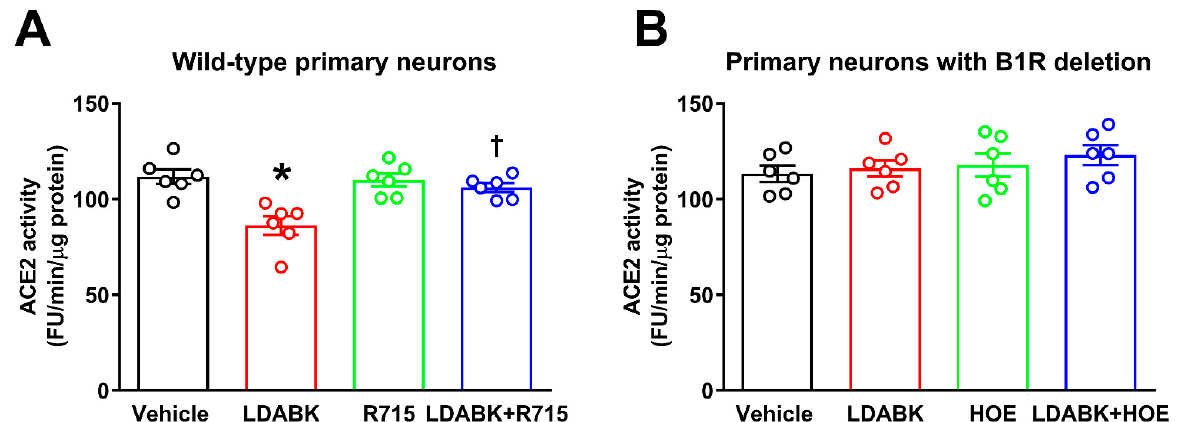
Figure 3. Effect of B1R activation on ACE2 activity in primary hypothalamic neurons. ( A ) Incubation of wild-type neurons with B1R-specific agonist LDABK significantly decreased ACE2 activity. R715, a B1R-specific antagonist pretreatment prevented this LDABK-mediated decrease in ACE2 activity. R715 treatment alone did not have any effect on ACE2 activity. ( B ) Treatment with LDABK did not show any effect on ACE2 activity in neurons with B1R deletion. In addition, the HOE 140, a B2R-specific antagonist also did not show any effect on ACE2 activity. The cultured primary neurons were pre-treated with a specific B1R antagonist (R715, 10 μ M) or a specific B2R antagonist HOE 140 (HOE, 10 μ M) for 1 h, followed by treatment with LDABK (300 nM) for 18 h ( n = 6 independent cultures/group). Statistical significance: one-way ANOVA followed by Tukey’s multiple comparisons test. * p < 0.05 compared to vehicle, † p < 0.05 compared to LDABK.